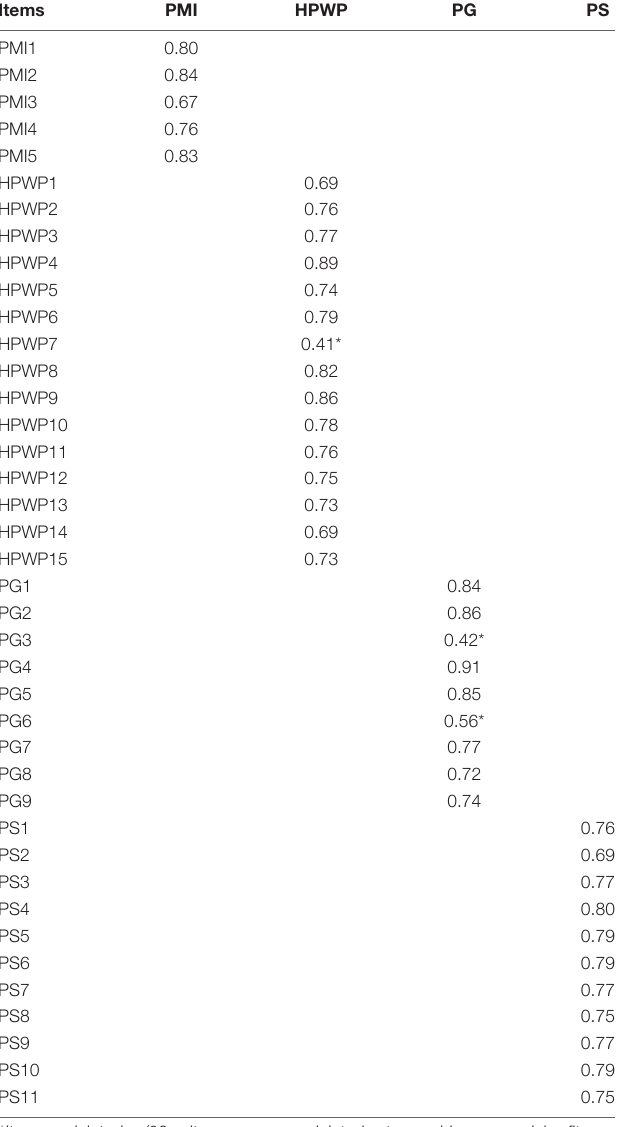
TABLE 4 | Confirmatory factor analysis: standardized